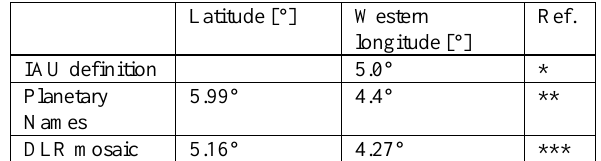
Table 2: Reported coordinates of crater Salih.